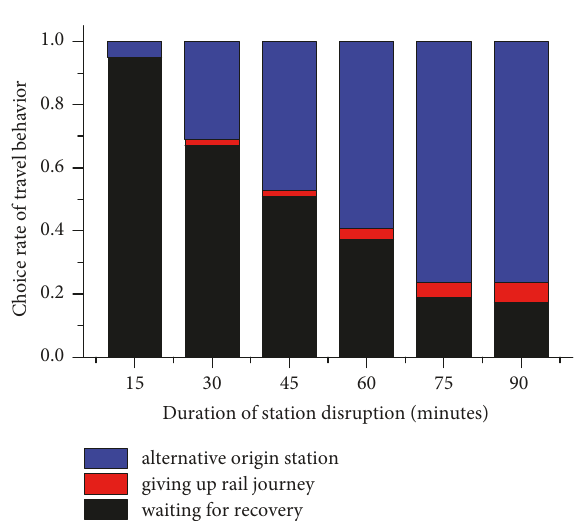
Figure 10: The relationship between the duration of station disrup- tion and the passenger behavioral